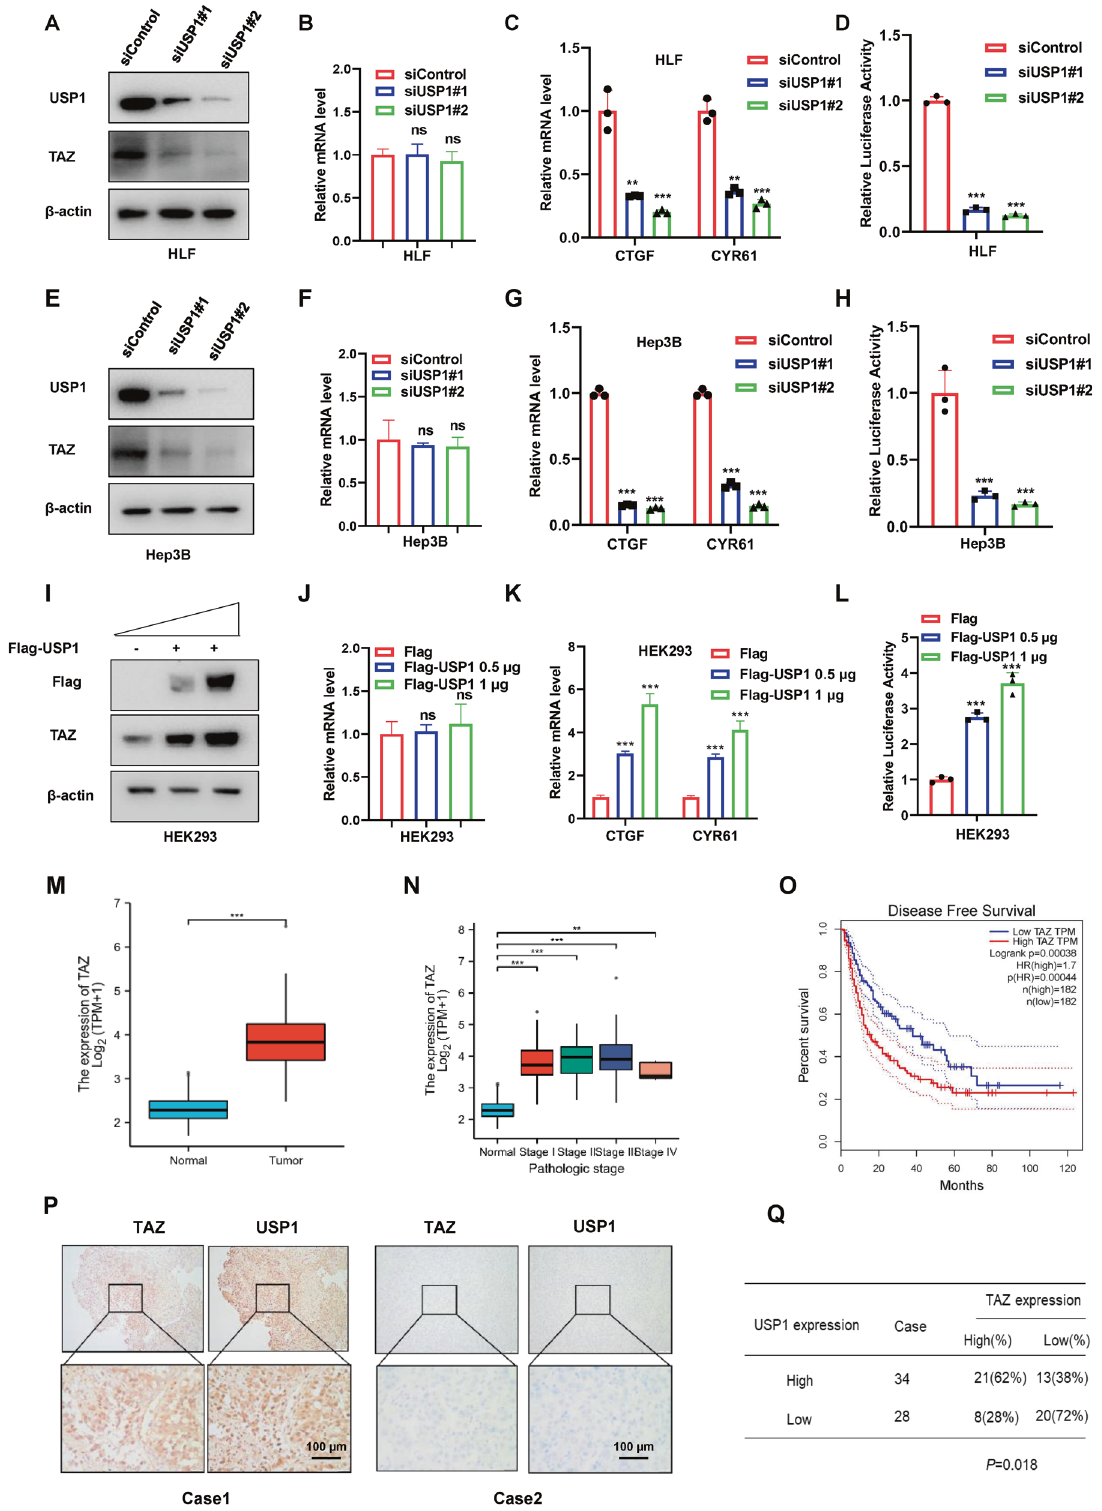
by Western blotting (Fig. 2A, E), while no signi fi cant change in mRNA expression was detected via qRT ‒ PCR (Fig. 2B, F). In addition, USP1 overexpression elevated the TAZ protein level (Figs. 2I and S1A, E). Gene expression analysis showed that USP1 depletion further decreased the expression of CTGF and